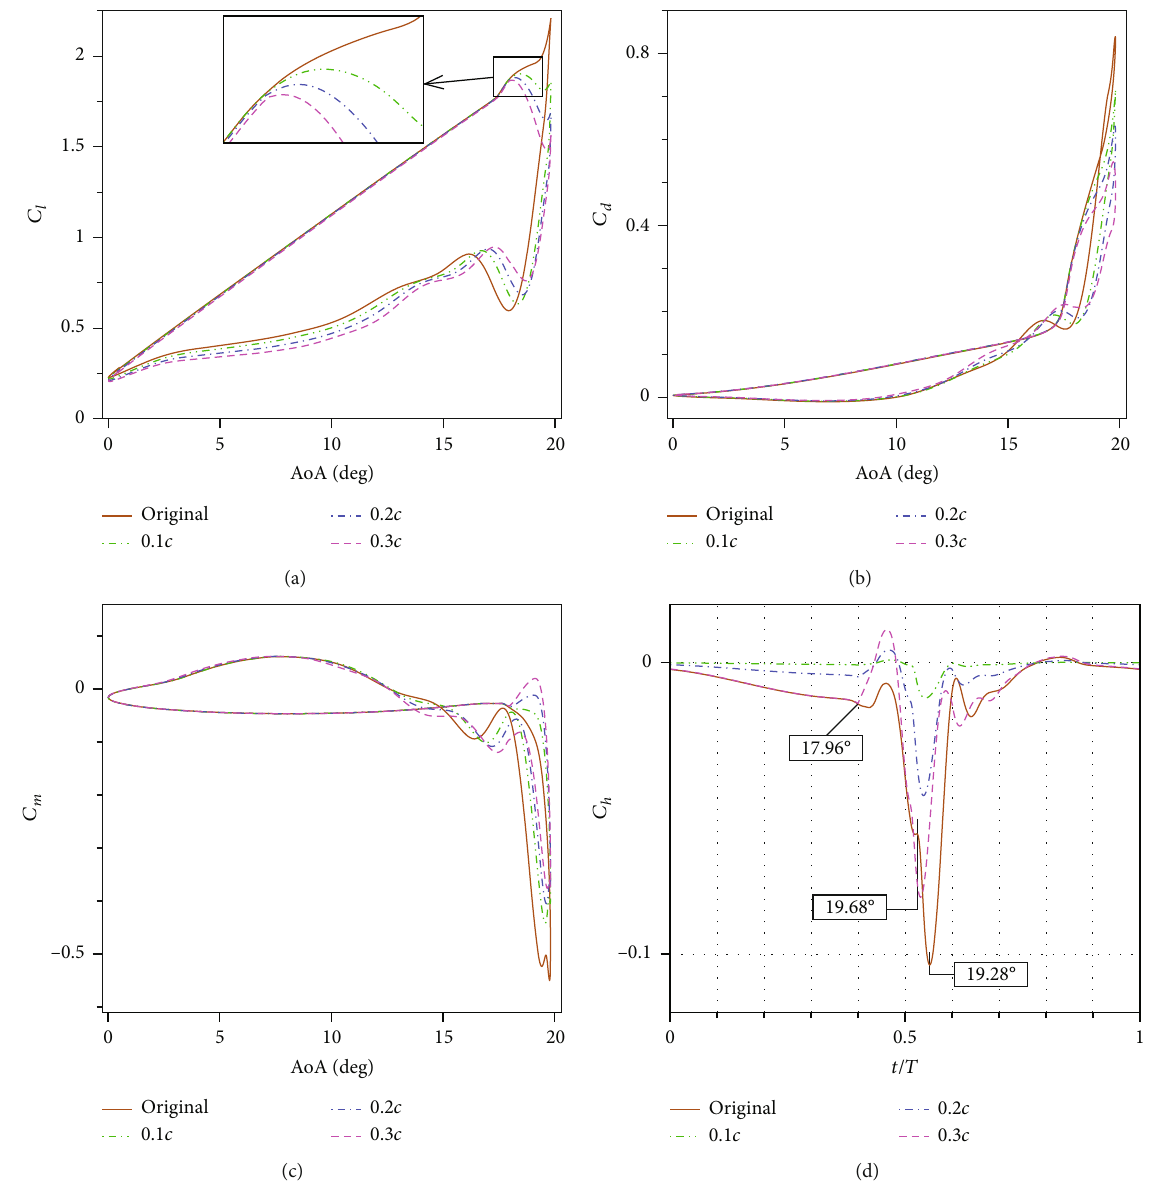
Figure 25: Comparison of aerodynamic force coe ffi cients for di ff erent relative chord lengths of the TEF: (a) lift coe ffi cients, (b) drag coe ffi cients, (c) pitching moment coe ffi cients, and (d) hinge moment coe ffi